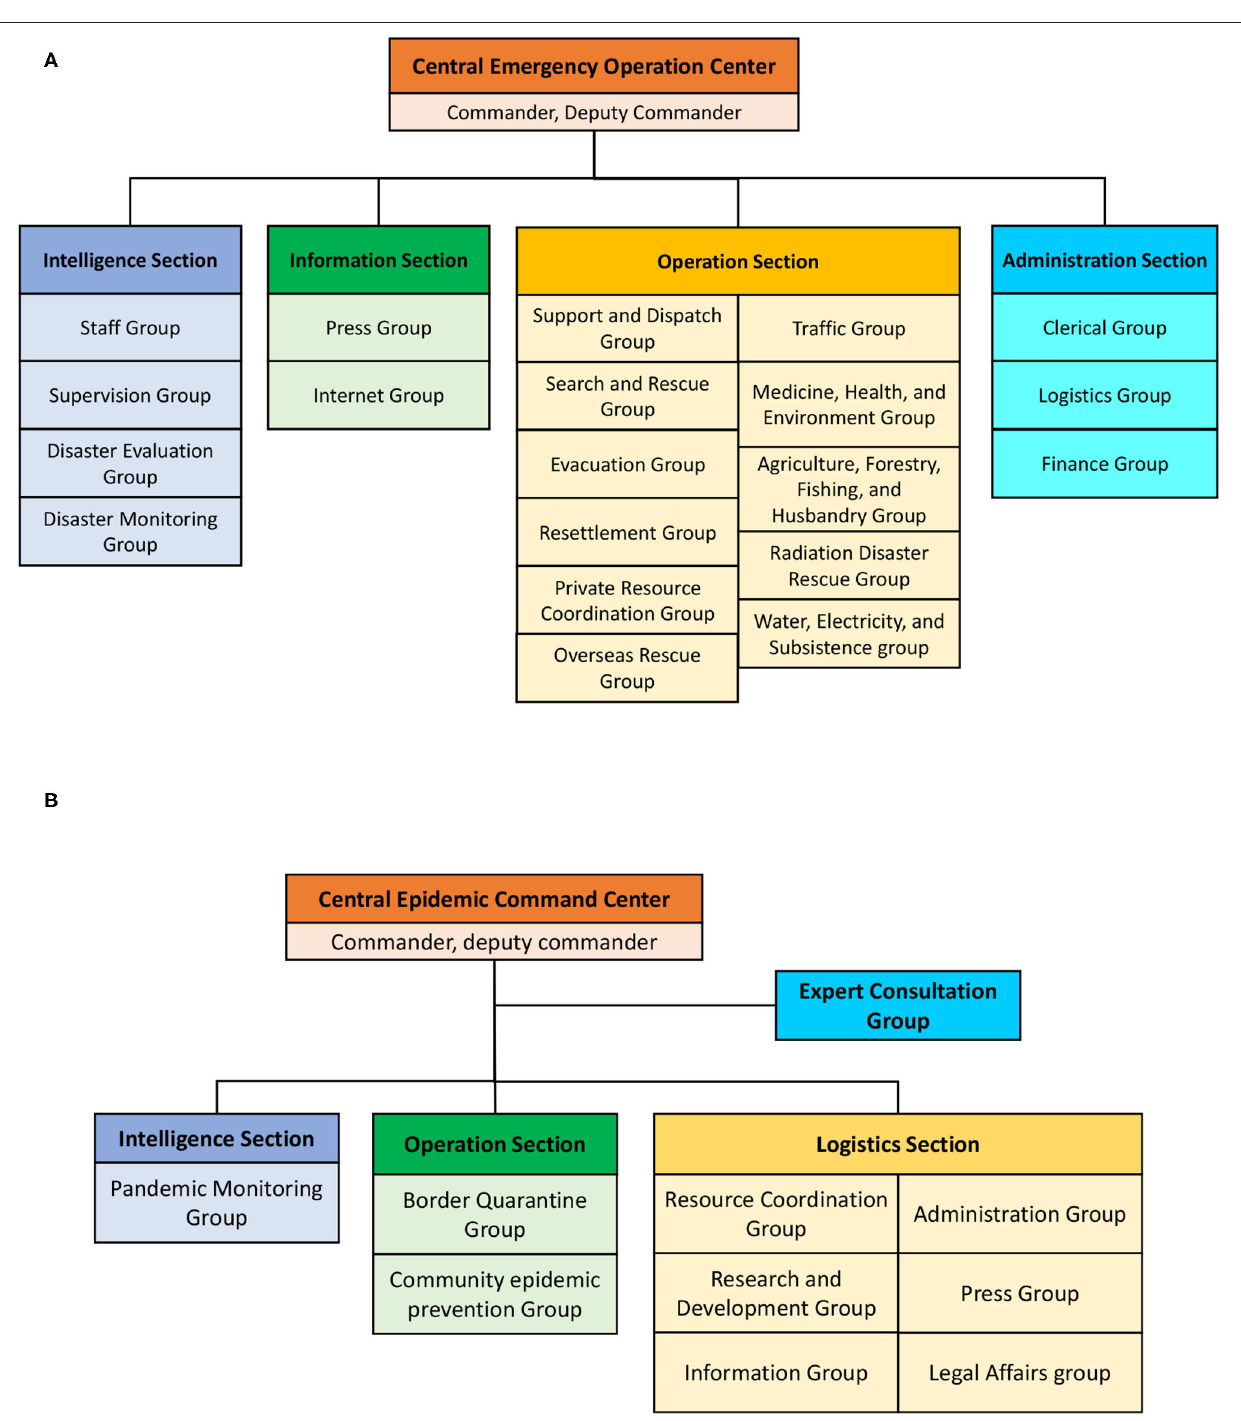
coordinated if a disaster affects a region across counties.